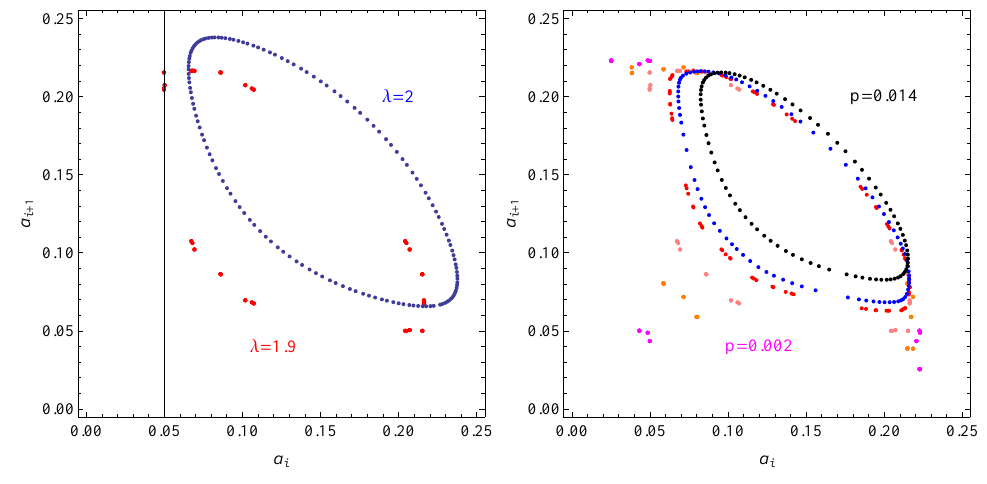
Figure 22: Ground state solutions represented in some sections of the phase-space ( a ) , i = 1,..., N . Left: a section of the Liouville torus ( λ = 2) and its destruc- , a i + 1 i tion at λ = 1.9, for p = 0.006, ξ = 2 and c = 55 / 144. Right: persistence of KAM tori at strong pressures away from integrable points and its eventual destruction at small pressures, with the same data as in Fig.